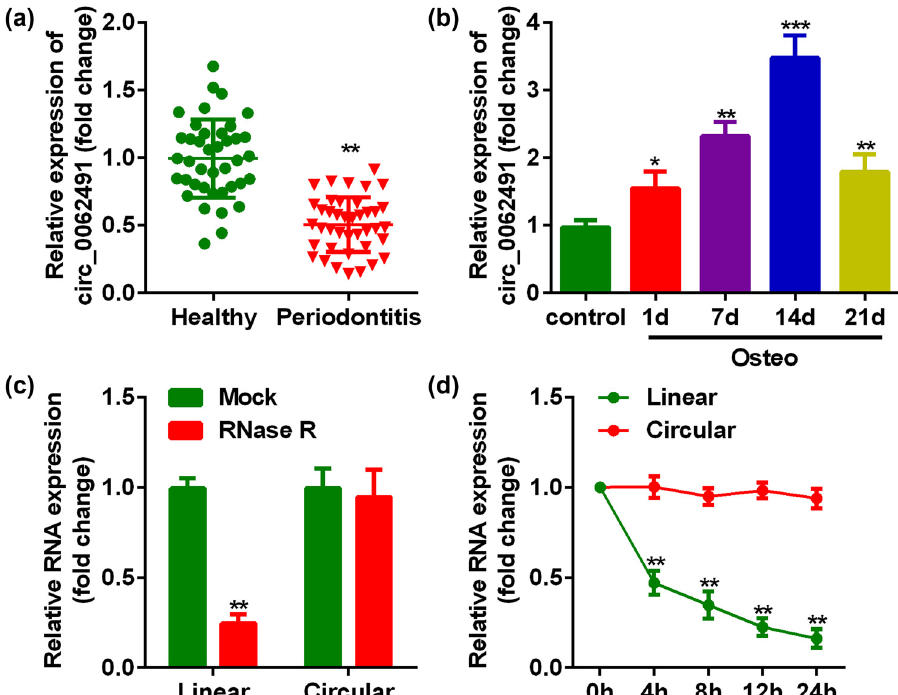
Figure 1: Expression levels of circ_0062491 in periodontitis tissues and cells. ( a ) The expression of circ_0062491 in PDL tissues was measured by qRT - PCR. ( b ) The expression of circ_0062491 in PDLSCs was determined by qRT - PCR. ( c ) qRT - PCR analysis for the expression of circ_0062491 and lnc_0062491 in PDLSCs after RNaseR treatment. ( d ) qRT - PCR analysis for the expression of circ_0062491 and lnc_0062491 in PDLSCs at the indicated time after treatment with actinomycin D. * p < 0.05, ** p < 0.01, *** p < 0.001. vs healthy, control, mock, and circular